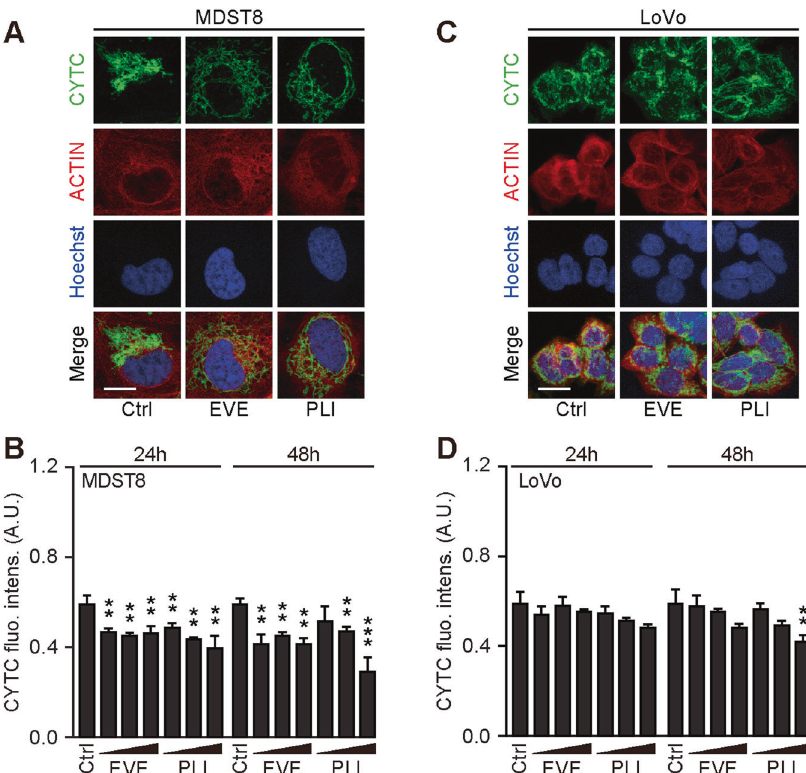
Fig. 3 Mitochondrial cytochrome c release in response to plicamycin treatment. Wild-type (WT) MDST8 and LoVo cells were treated 25, 50, or 100 nM plicamycin (PLI) or 10 nM, 100 nM, 1 µM everolimus (EVE) for 24 h or 48 h followed by immuno fl uorescence staining with antibodies speci fi c for cytochrome c and subsequent assessment by confocal microscopy. Representative images of cells in each condition are shown. Scale bars represent 10 μ m. A , C Images were quanti fi ed of cytoplasmic cytochrome c intensity and are reported as a bar chart ( B , D ). Error bars indicate SEM. Asterisks refer to signi fi cant effects for treatments versus control (paired Student ’ s t test; ** P < 0.01, *** P <